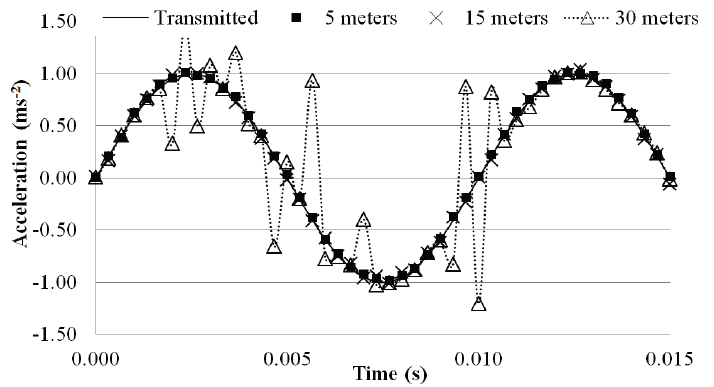
Figure 11. Time histories of wirelessly transmitted signal (Indoor).